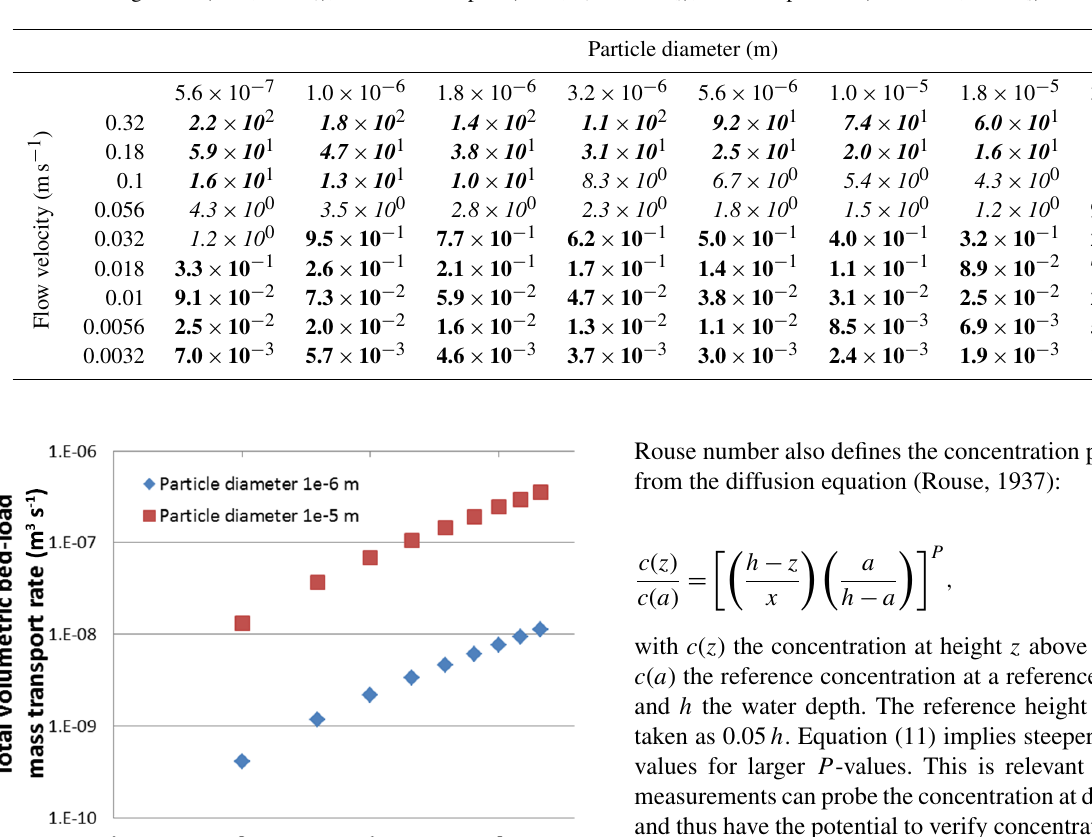
Table 3. Ratio of actual Shields numbers to threshold Shields numbers for incipient motion ( θ/θ rs ) as a function of particle diameter and bulk flow velocity of water. Color coding refers to the prevalent transport domains (see Fig. 1 and the accompanying text) for each parameter combination: stagnation (bold, θ < θ c ), bed-load transport (italic, θ c ≤ θ < θ rs ), and resuspension (bold italic, θ ≥ θ rs ).